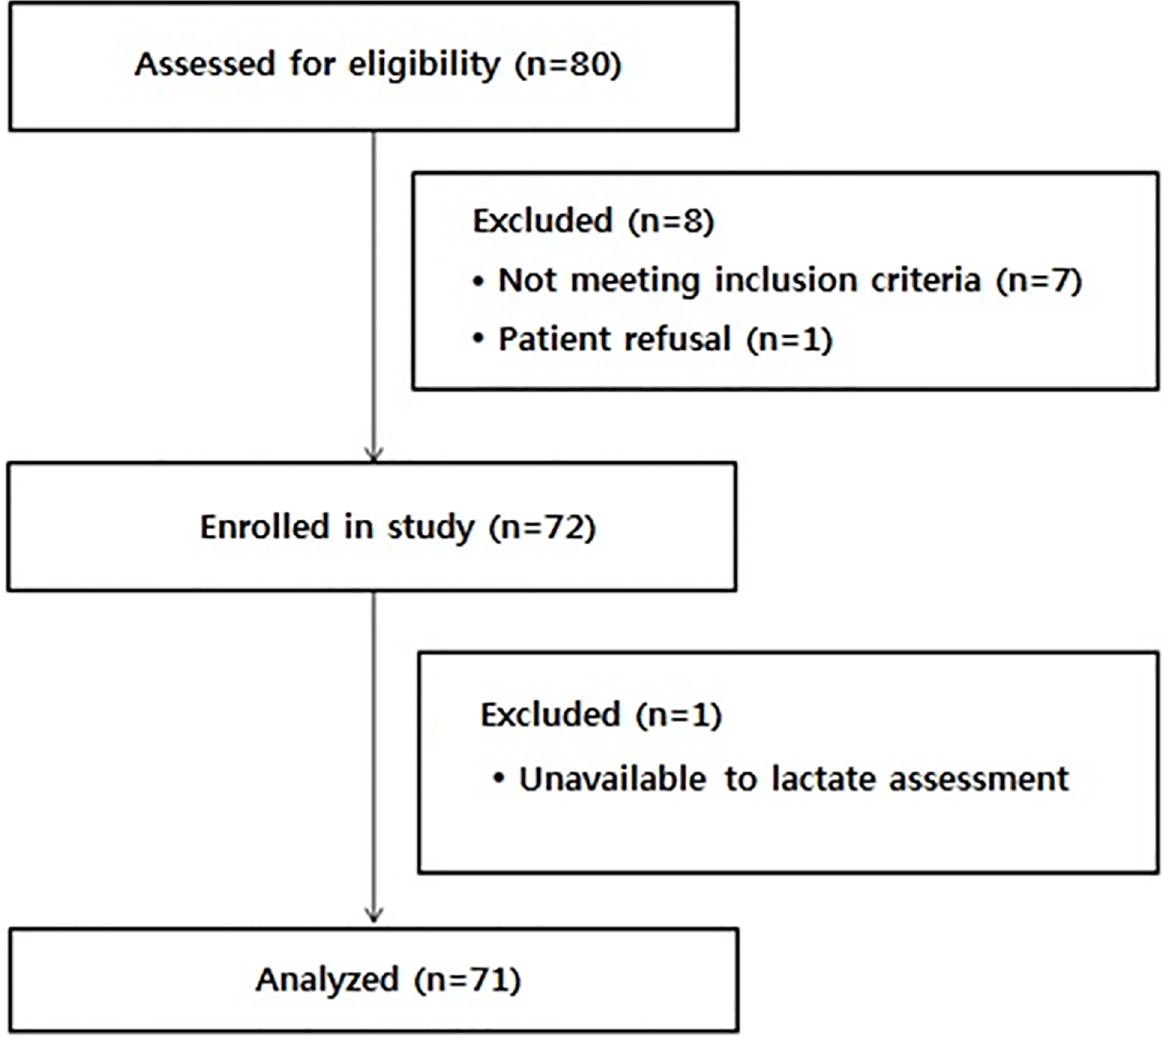
Fig 1. Flow diagram of study